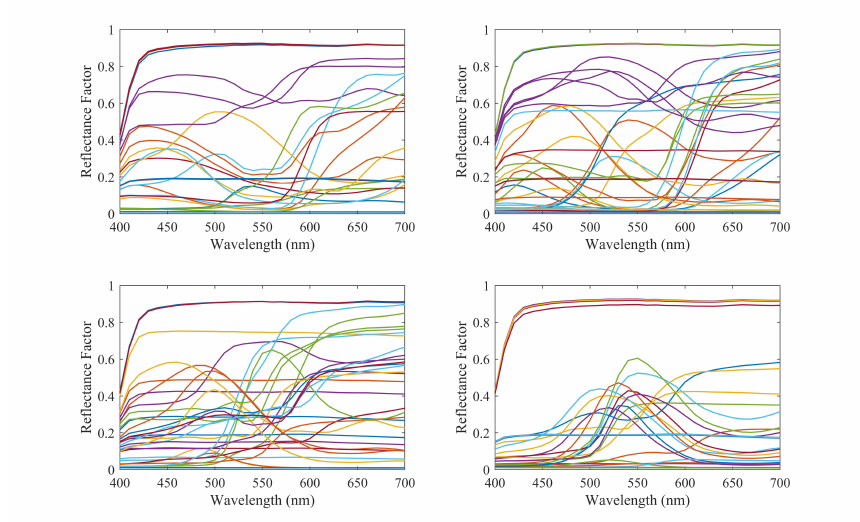
Figure 2. Spectral curves of the samples in the training dataset.